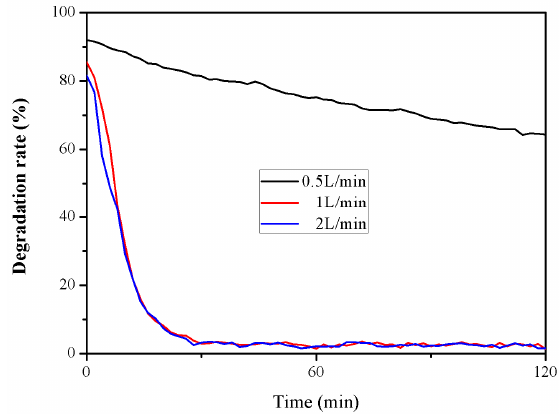
Figure 12. Effect of air velocity on ammonia degradation.